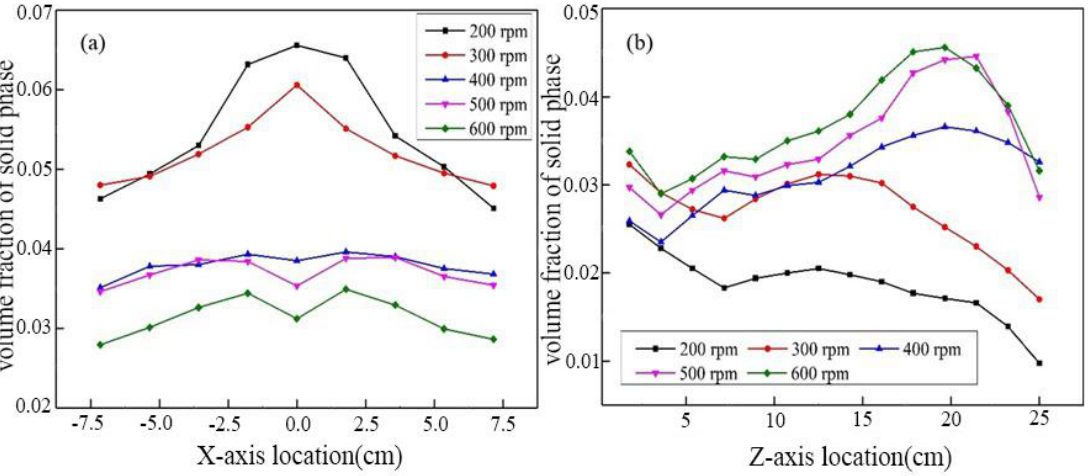
Figure 6. ( a ) Solid phase volume fraction distribution at different agitation speeds; ( b ) solid volume fraction distribution at different agitation